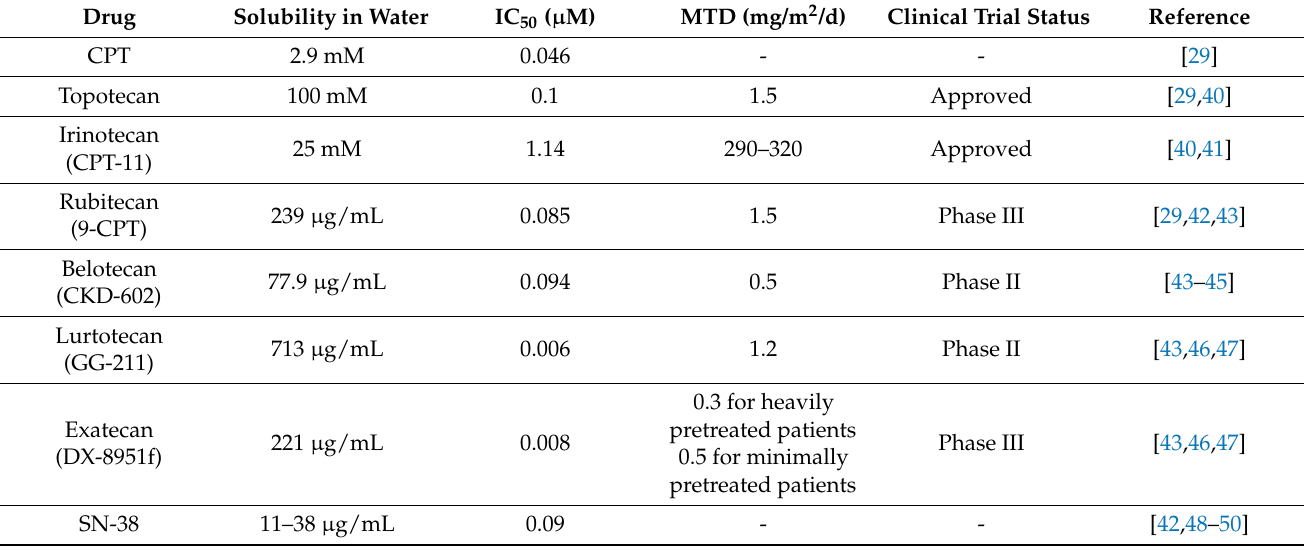
Table 1. Characteristics of CPT and its analogues; water solubility, drug concentration required to inhibit 50% of cell growth (IC 50 ), maximum tolerated dose (MTD), and clinical trial